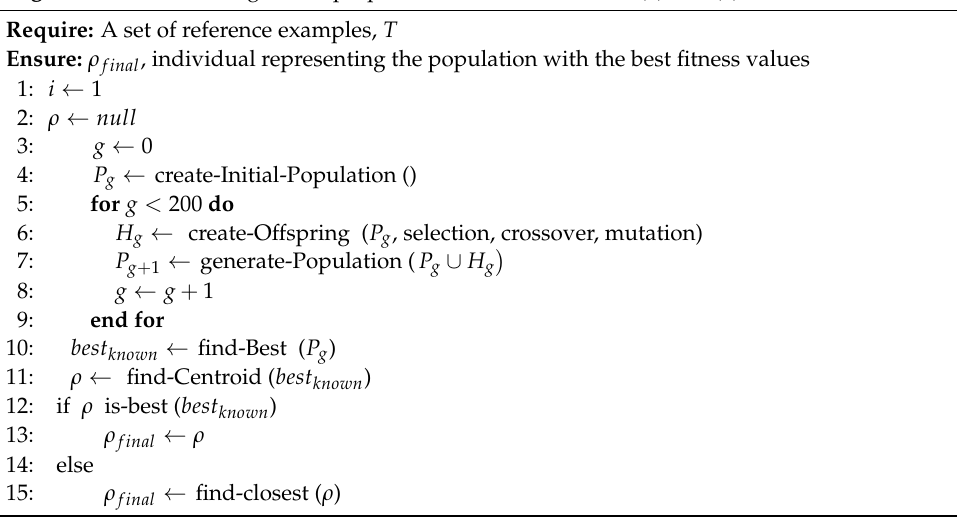
Algorithm 1. Genetic Algorithm proposed to address Problems (1) and Algorithm 1 . Genetic Algorithm proposed to address Problems (1) and (2).